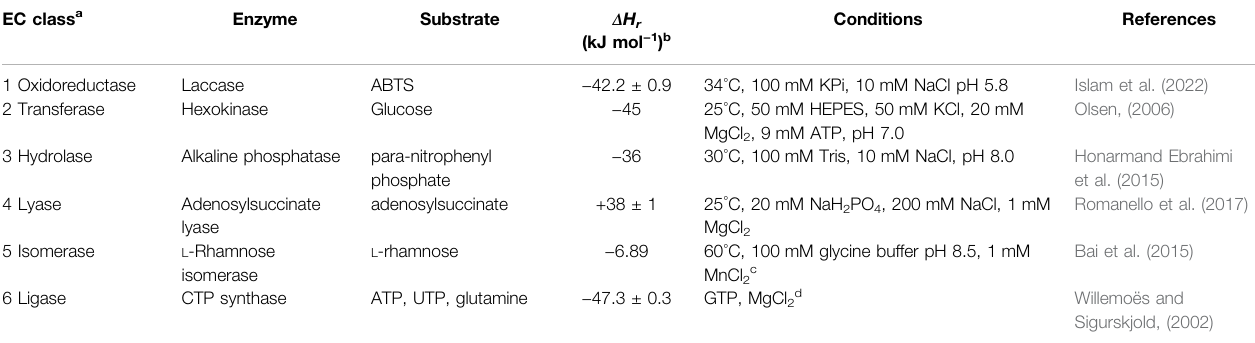
TABLE 1 | The universality of enzyme calorimetry characterized by the apparent reaction enthalpies for enzyme reactions observed with ITC. EC class